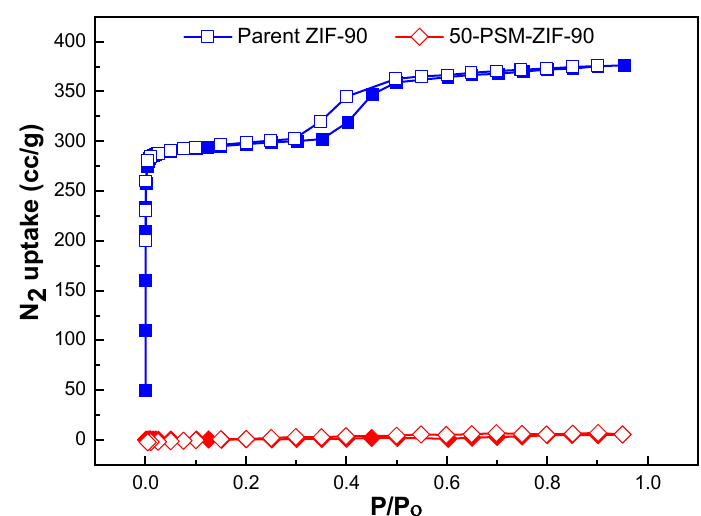
Figure 7. N 2 adsorption isotherms of ZIF-90 and 50-PSM-ZIF-90 at 77 K.